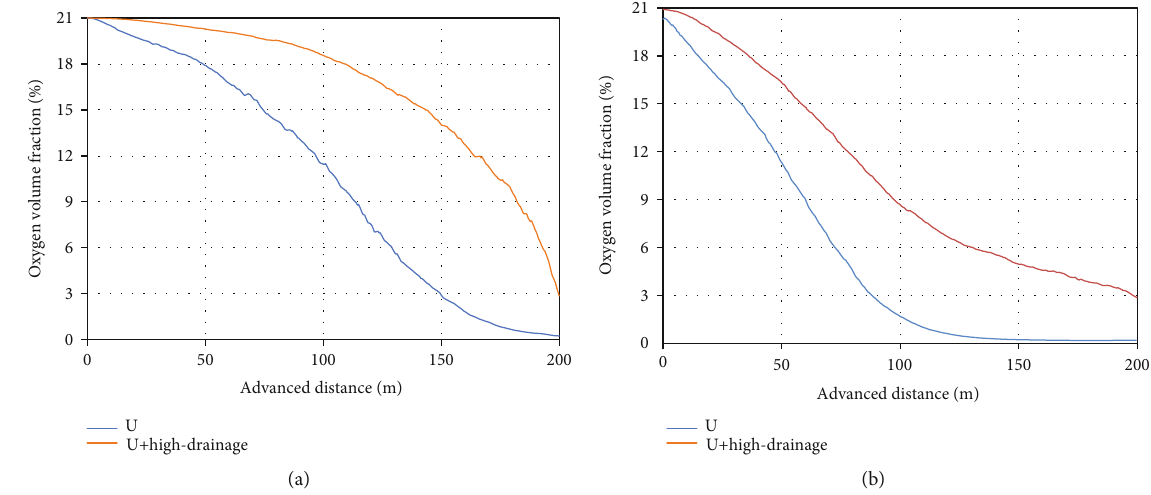
Figure 11: Volume fraction of oxygen in intake (a) and return (b) airway before and after high